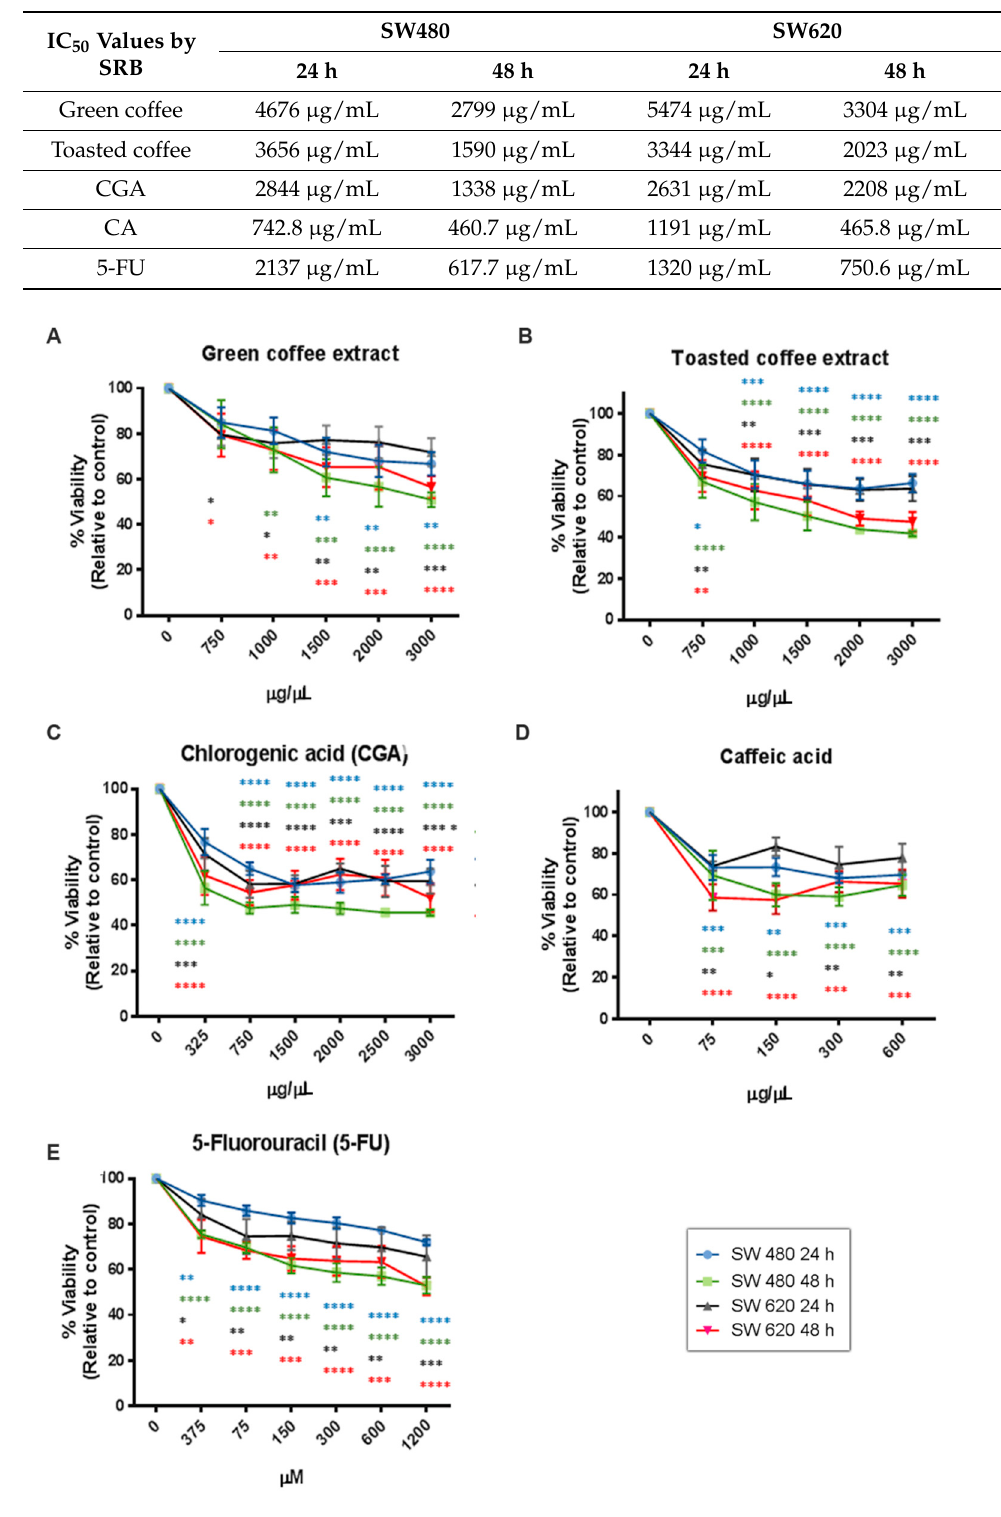
Figure 4. Cytotoxicity activity measured by SRB in the colorectal cancer cell lines SW480 and SW620. GC ( A ), TC ( B ), CGA ( C ), CA ( D ), and 5-Fu ( E ). Values are expressed as mean ± SEM of at least three independent experiments. Two-way ANOVA, difference to non-treated cells, * p ≤ 0.05, ** p ≤ 0.01, *** p ≤ 0.001, **** p ≤ 0.00001.